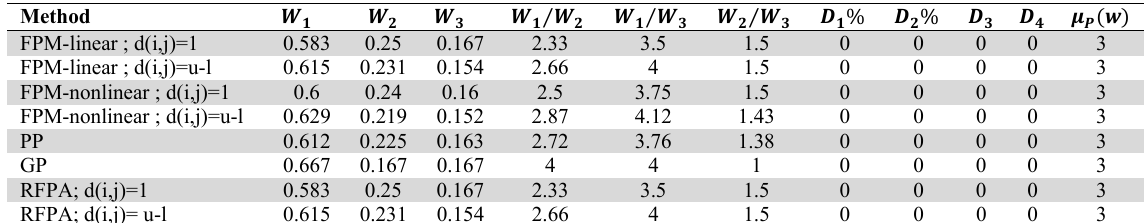
Three-dimensional consistent judgments Method